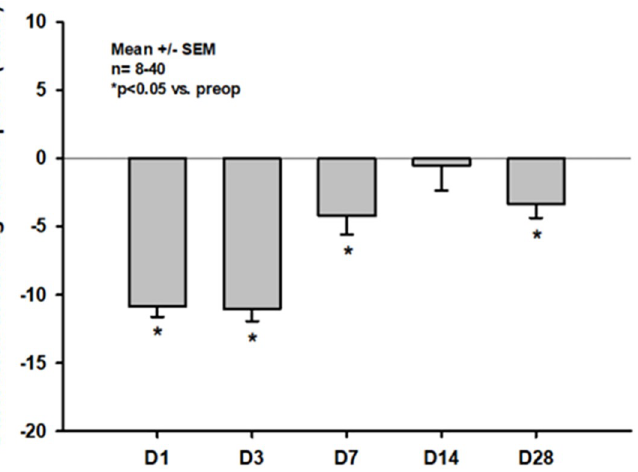
Fig 7. Differences in average run speed compared to pretrauma status on days one thru 28 after CCI.